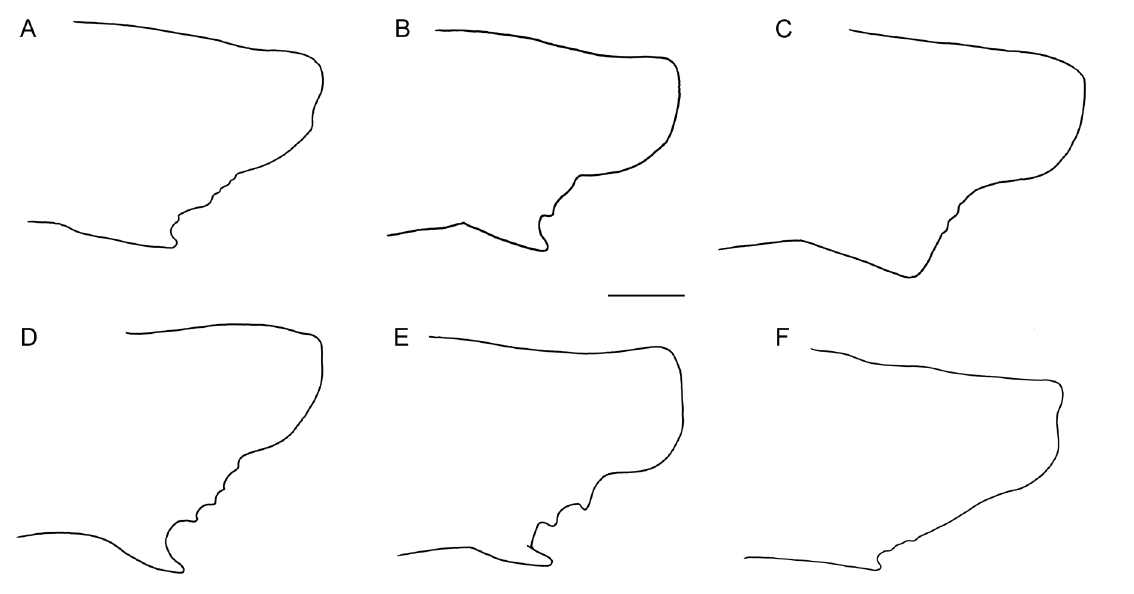
Fig. 22. Apical part of male metafemur, lateral view. A–C . Merodon lotus Vujić & Radenković sp. nov. Paratypes. A . Specimen FSUNS (FSUNS ID ZA6_052). B . Specimen FSUNS (FSUNS ID ZA6_060). Specimen FSUNS (FSUNS ID ZA6_066). D–F . M. zebra Vujić & Radenković sp. nov. D . Holotype (RMCA; FSUNS ID 25089). E . Paratype (NBCN; FSUNS ID 05174). F . Paratype (RMCA; FSUNS ID 25090). Scale bar = 1